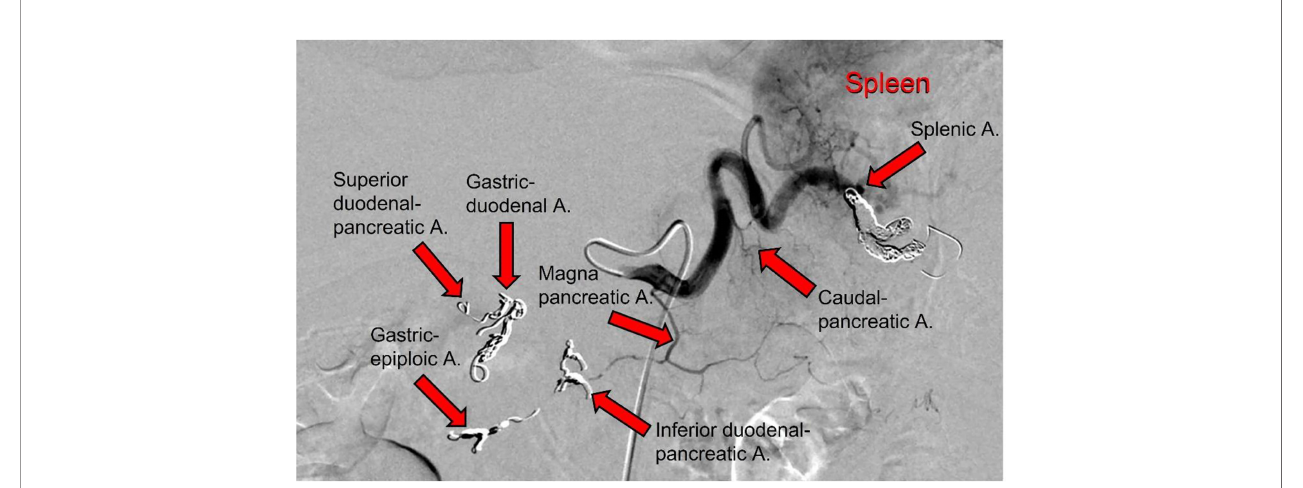
FIGURE 3 | Angiographic scan following injection of contrast medium through the splenic artery after the completion of the technical procedure. The following arteries were embolized, as indicated (arrows): gastric-duodenal a.; superior duodenal-pancreatic a.; gastric-epiploic a.; inferior duodenal-pancreatic a.; and